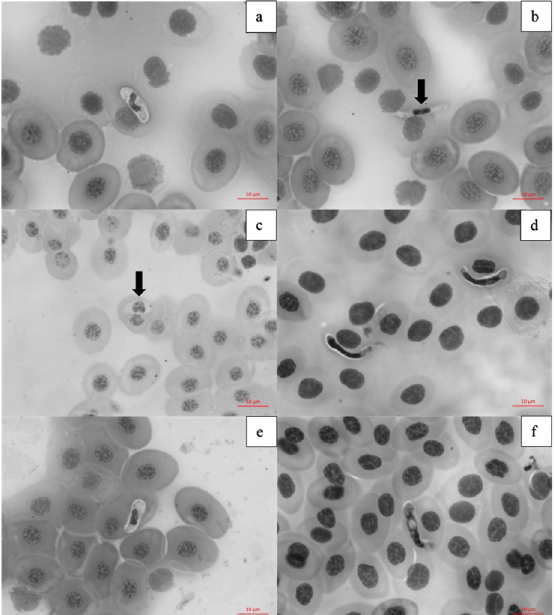
Figure 3. Hemoparasites of the phylum Apicomplexa in the peripheral blood of the anurans sampled in forest and oil palm plantations, Eastern Amazon, Brazil: a ( Leptodactylus pentadactylus ); b ( L. pentadactylus ); c ( L. macrosternum ); d ( L. pentadactylus ); e ( L. pentadactylus ); f ( L. pentadactylus ). Scale = 10 µm. Species between parentheses =